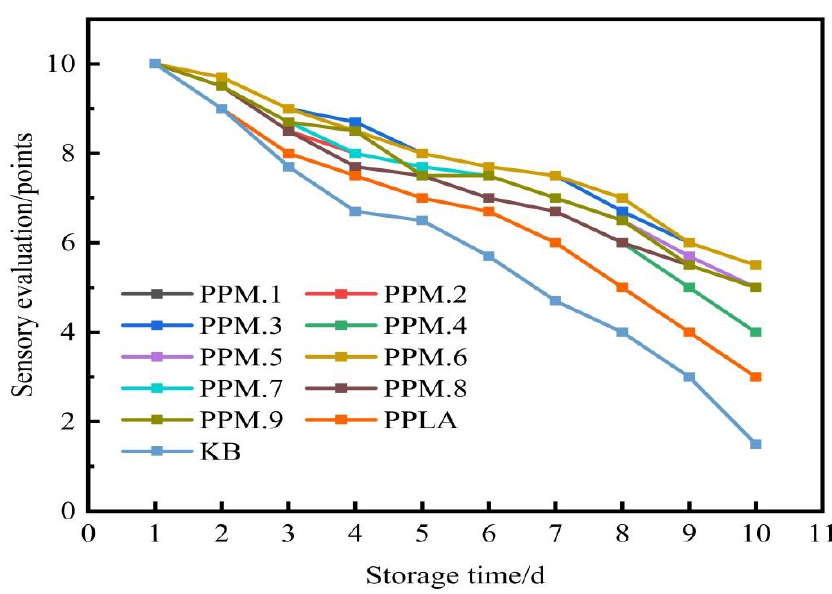
Figure 10. The effect of the addition of the assembly on the sensory evaluation of strawberries.